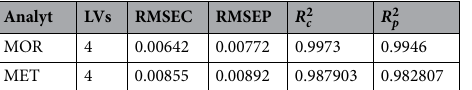
Table 2. Evaluation of PLS results for the detection of MOR and MET.